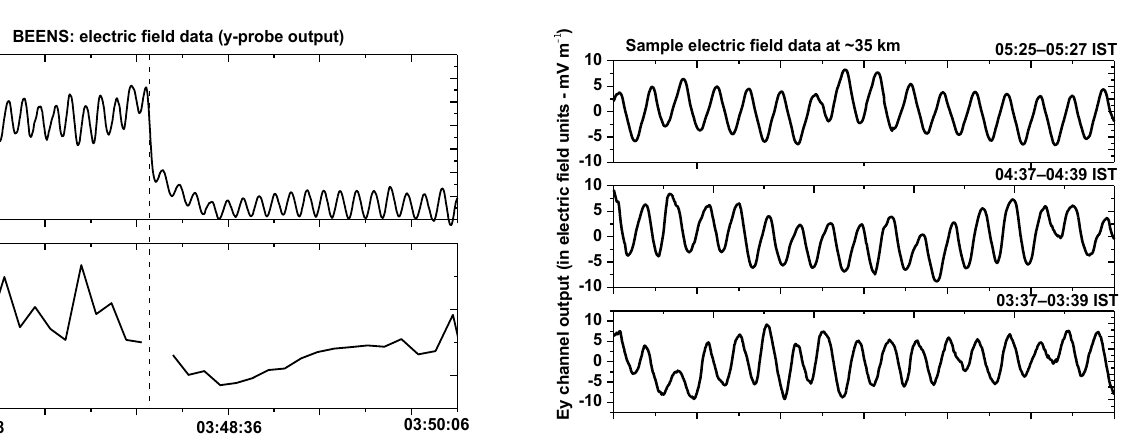
Figure 13. Sample electric field data at the float altitude of 35km for the three different 2min time segments. The DC offsets were removed in this